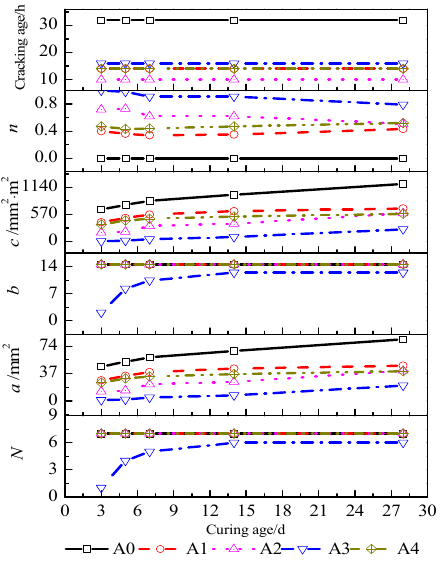
Figure 11. The evaluating indicator of the flatknife-edge test.